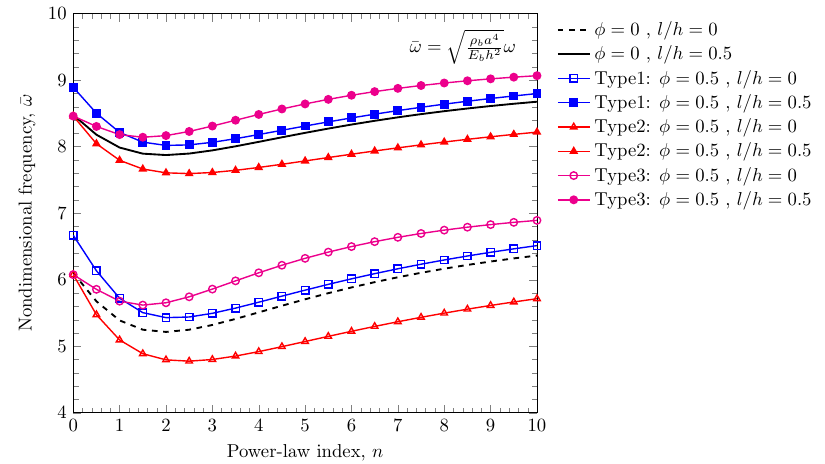
Figure 8. Non-dimensional fundamental frequency, ¯ ω versus power-law index, n .